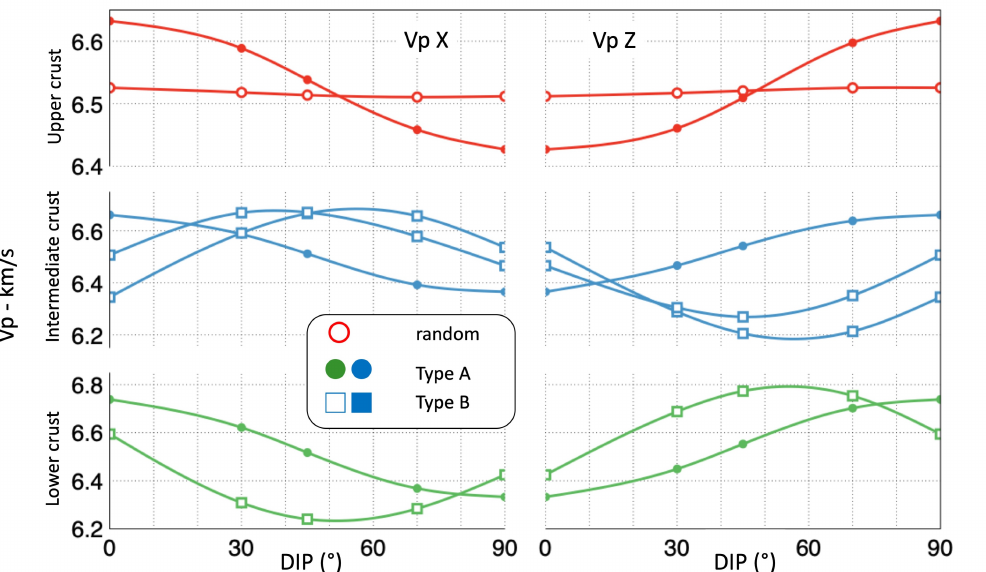
Figure 10. Vp crustal section. upper crust = red, intermediate crust = blue, lower crust = green. Texture types: random = hollow circle; A = circle; B =